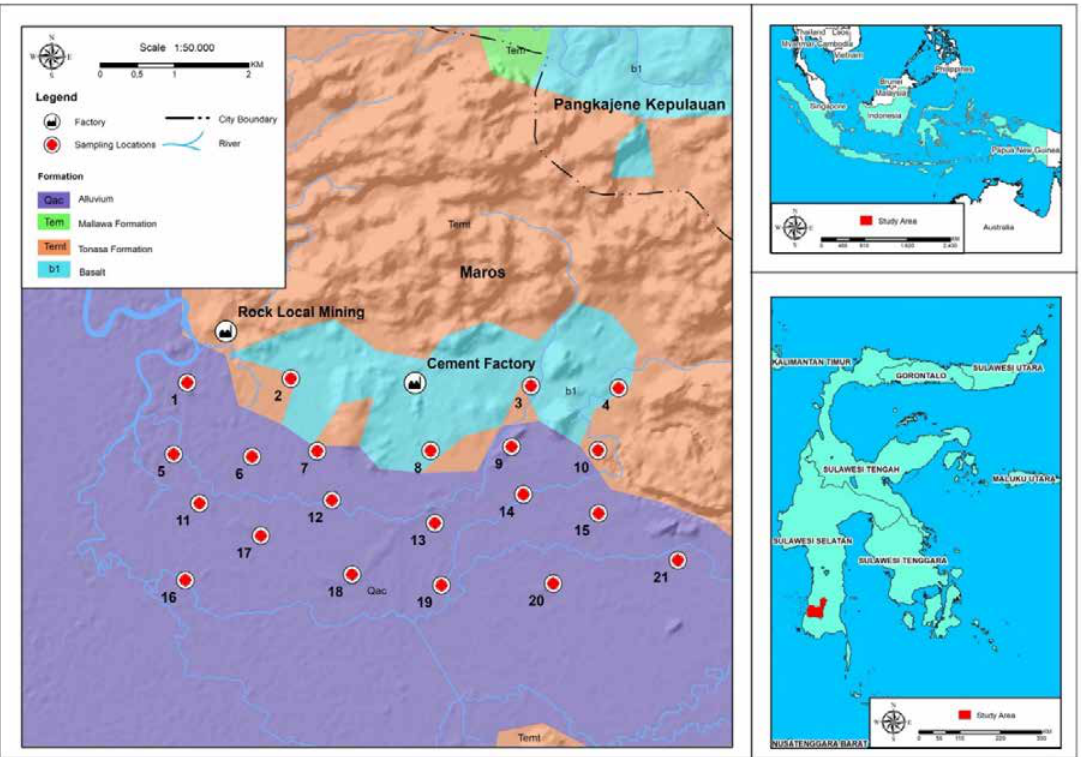
Fig. 1: Geographic location of the study area along with the sampling locations of PM 2.5 in the in four major sub- districts in Indonesia